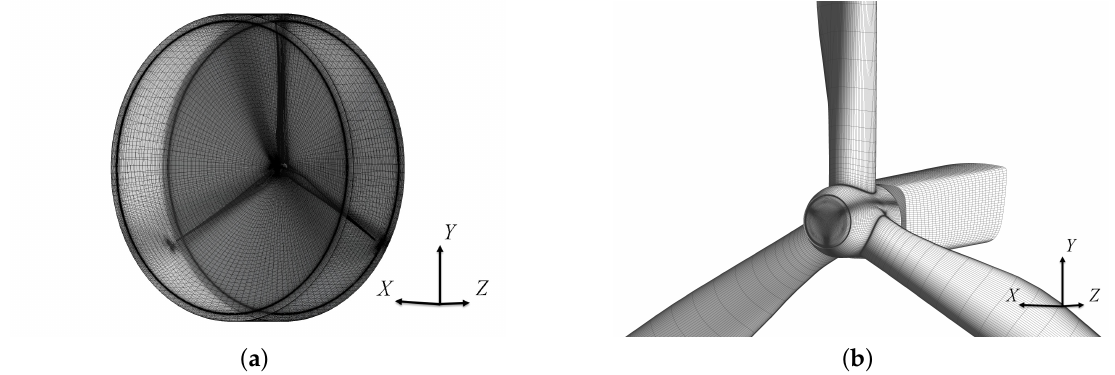
Figure 3. Computational mesh of the wind turbine. ( a ) Mesh in rotational domain. ( b ) Mesh on the rotor-nacelle